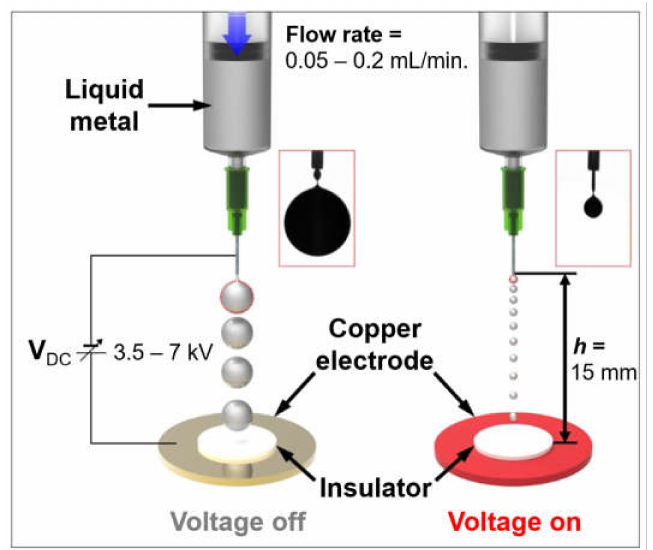
Figure 1. Schematic of electro-hydrodynamic gallium-based liquid metal droplet generation accord- ing to the applied high voltage between a needle and circular-shaped Cu